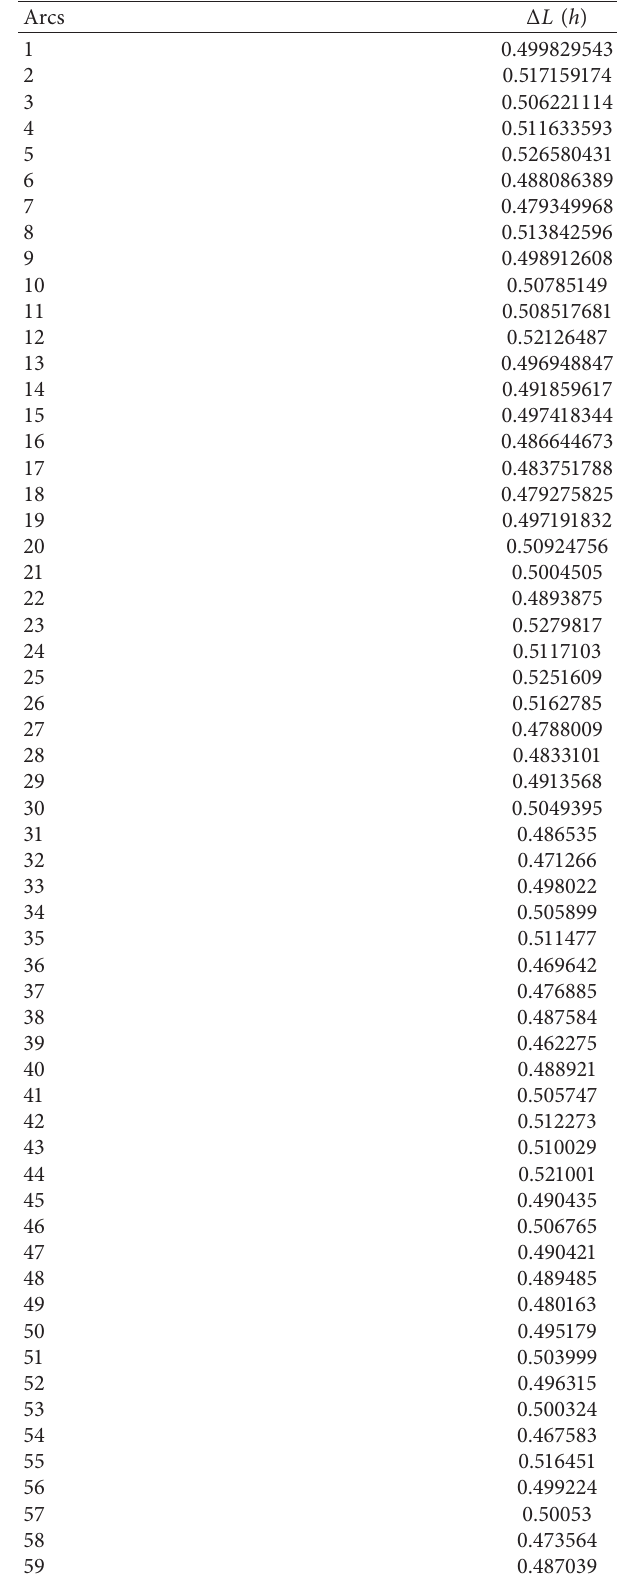
Table 8: Calculation results of traffic performance change value of road network under